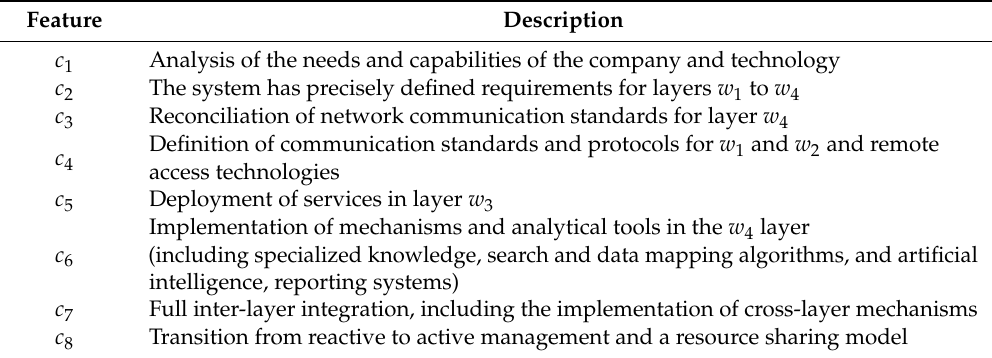
Table 2. Definition of the general features of the framework